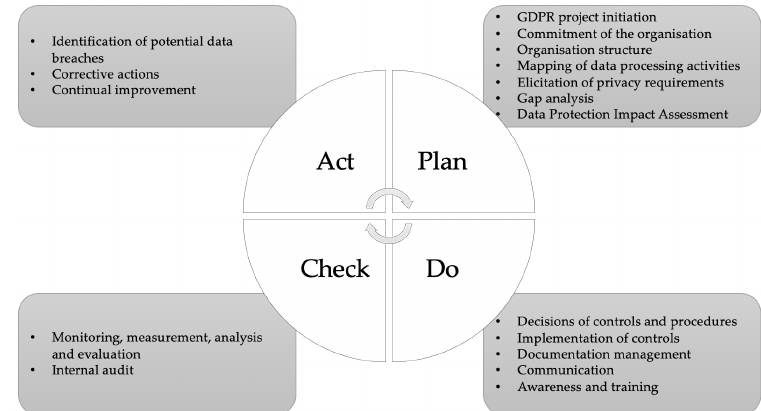
Figure 1. PDCA model of a GDPR compliance